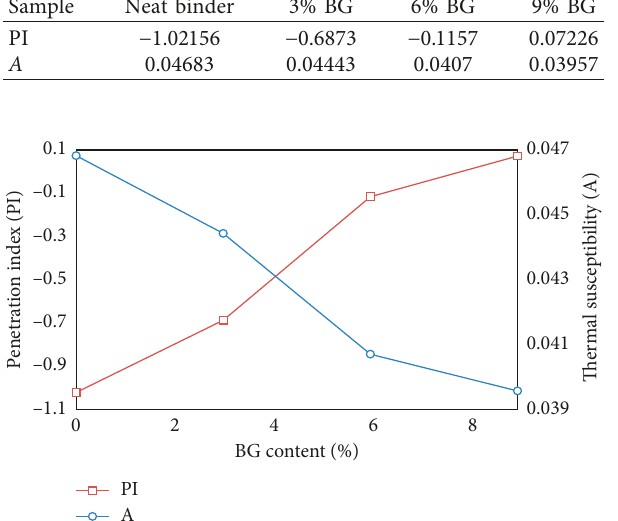
Figure 7: Master curve for G ∗ at 58 ° C.